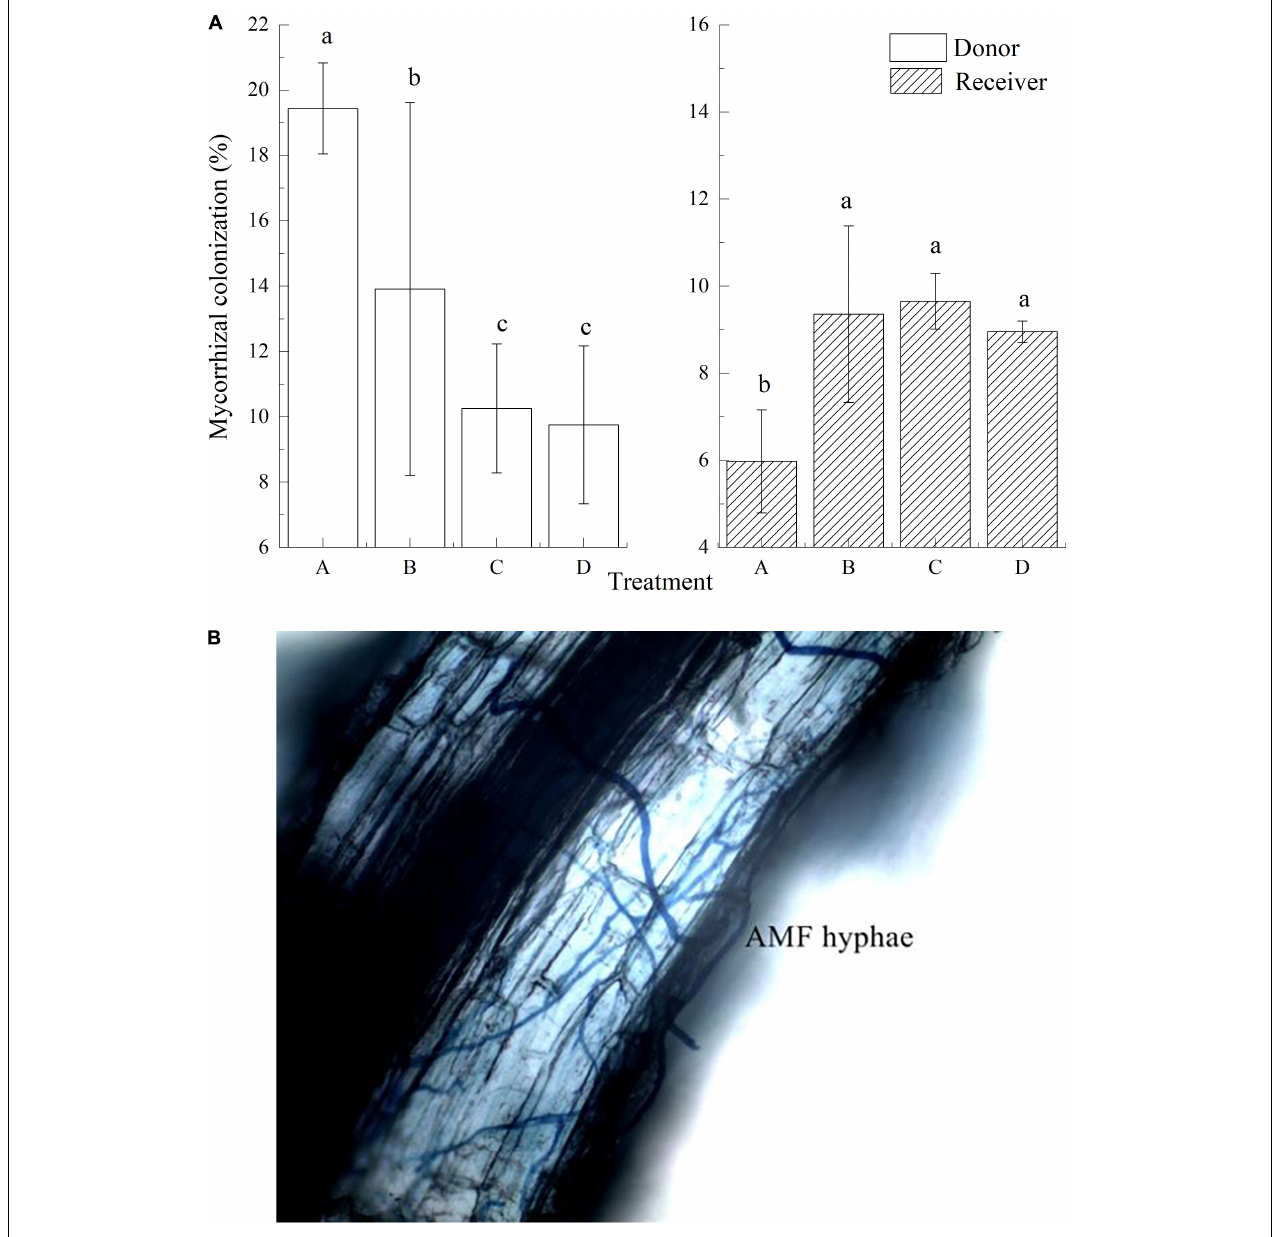
FIGURE 2 | Mycorrhizal colonization and AMF hyphae of donor and received plants in different treatments. Data are mean ± SD (n = 3); different letters indicate significant difference ( P <